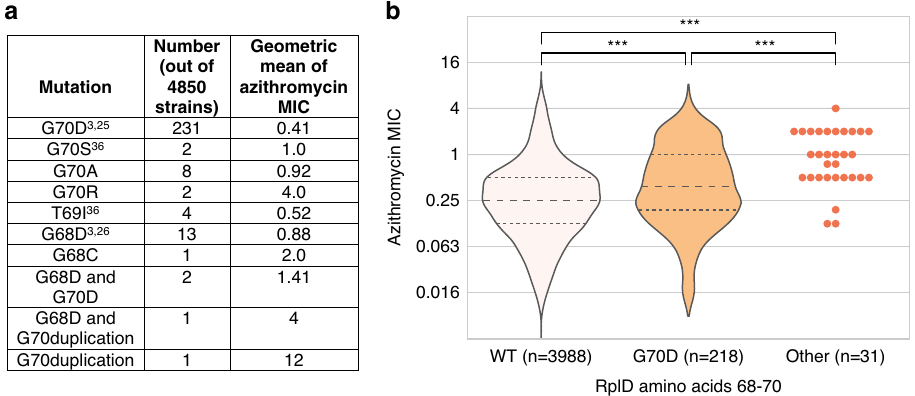
Fig. 3 Varied RplD macrolide binding site mutations are associated with increased azithromycin MICs. Mean ( a ) and distribution ( b ) of azithromycin MICs for RplD macrolide binding site variants. Previously reported mutations are cited with the fi rst reporting publications. Violin and swarm plots and statistical analyses were limited to isolates with MICs < 8 to exclude isolates with 23S rRNA mutations. Rare RplD mutations (denoted as “ Other ( n = 31) ” ) were grouped for visualization and statistical analysis, and thus were assumed to all have the same effect. Quartiles within violin plots are depicted using dotted lines. Statistical signi fi cance between RplD variants and RplD wildtype MIC distributions was assessed by two-sided Mann – Whitney U Test: * p < 0.05, ** p < 0.01, and *** p < 0.001. Exact p -values from left to right were 3.09 × 10 − 7 (WT vs. G70D), 3.91 × 10 − 10 (WT vs. Other), 5.74 × 10 − 5 (G70D vs.